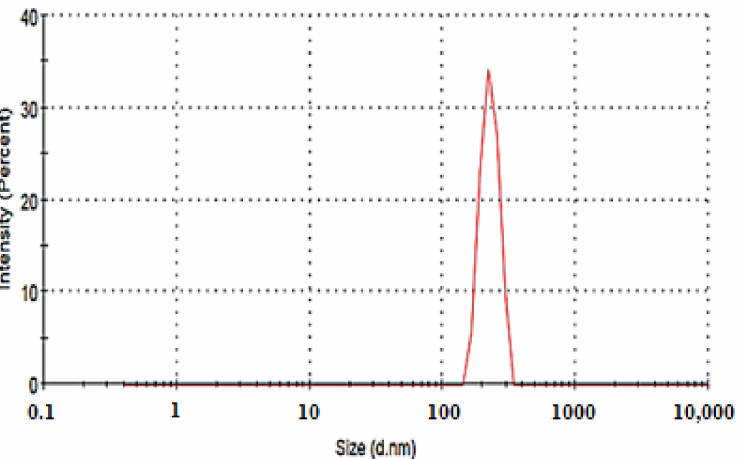
Figure 12. Particle size distribution curve of the optimized EGCG-loaded spanlastic formula (F4). Abbreviation: EGCG, epigallocatechin